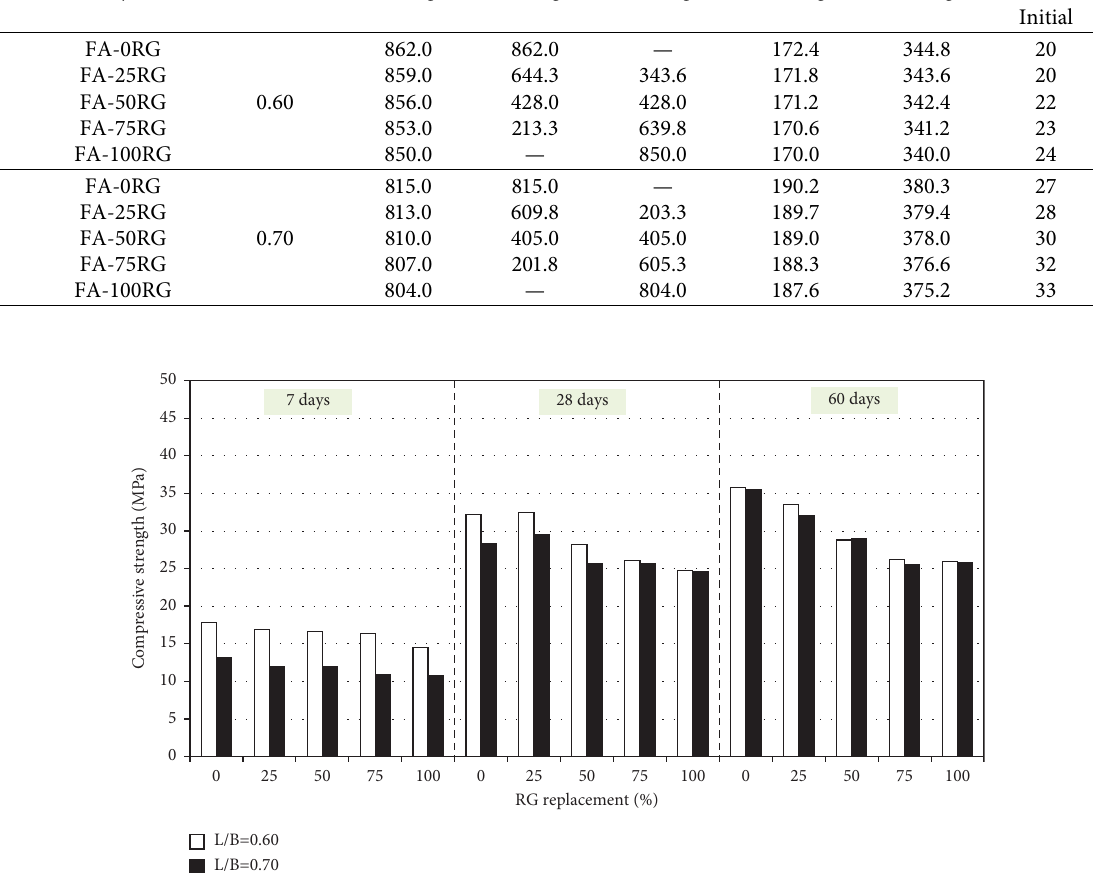
(1) and displayed in Figure 5. Te constants in equation (1) were derived by curve-ftting the fndings of RG contents at 0%, 25%, 50%, 75%, and 100%. Te curve ftting produced an R 2 value of 0.892, which is good for engineering applications f ′ c,d � 0 . 27453 ln ( d ) + 0 . 00258 , ( 1 ) f ′ c, 28